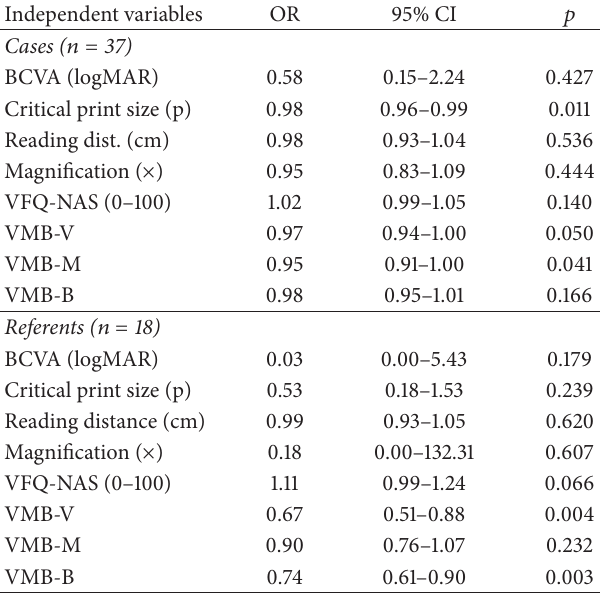
Table 4: Univariate GEE logistic analysis odds ratio for perceived health compared with perceived poor health among AMD patients and age-matched referents with normal